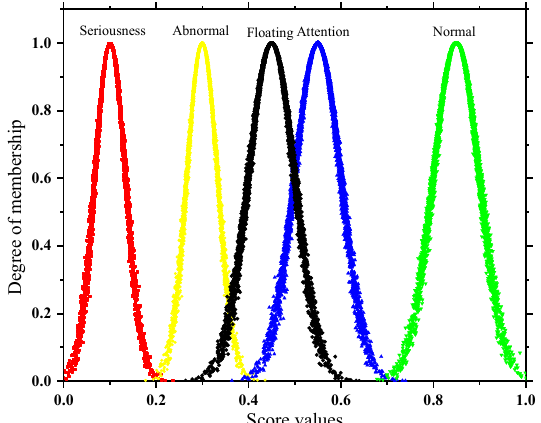
Figure 10. Membership degree of x 33.